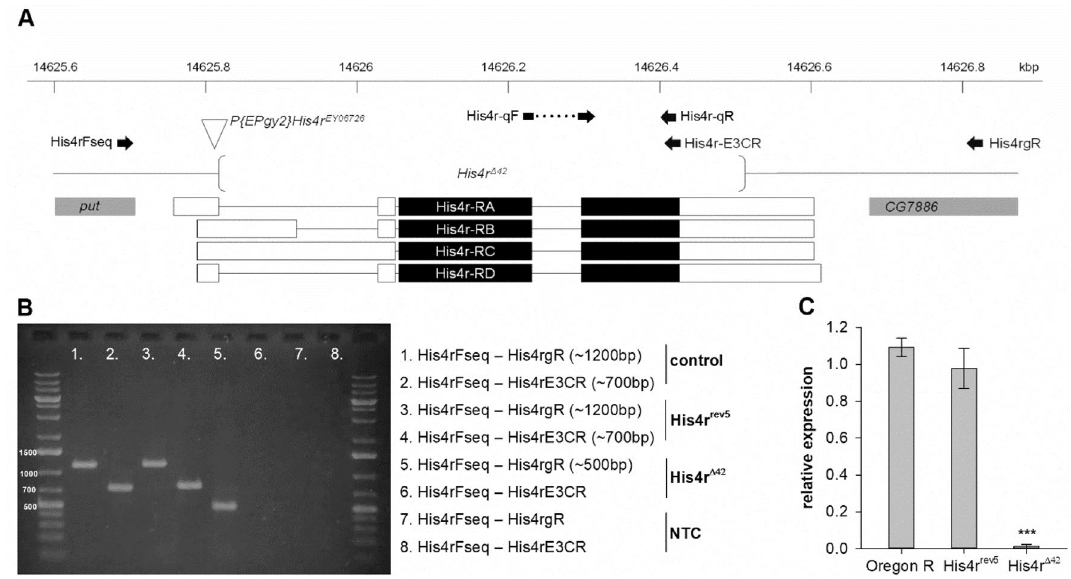
Figure 1. Generation and validation of the His4r Δ42 deletion mutant. (A) The genomic region of His4r on chromosome arm 3R with transcript models, primers and the extent of the deletion is shown. On the His4r transcript models coding sequences are represented by black bars, untranslated exonic regions by empty bars, and introns by solid lines. Adjacent ends of neighboring genes ( put and CG7886 ) are shown with grey bars. Empty arrowhead indicates the position of the P{EPgy2}His4r EY06726 transposon in the His4r 5 ′ -UTR, brackets show the breakpoints of the His4r Δ42 deletion. Position of PCR primers are marked by black arrows. (B) PCR reactions on homozygous His4r Δ42 template with His4rFseq and His4r-E3CR primers did not give a PCR product, with His4rFseq and His4rgR primers the length of the product was approximately 700 bp shorter than on wild-type control template. PCR reactions on His4r rev5 templates resulted in amplicons similar to wild- type. (C) His4r transcript levels were similar in Oregon-R (wild-type) and in His4r rev5 revertant flies (P > 0.05), while in His4r Δ42 mutants His4r mRNA was not present (P = 2.69077 × 10 −5 , t-test). The bars show the mean of normalized RT-qPCR measurements relative to a template dilution series, error bars represent standard error, n =